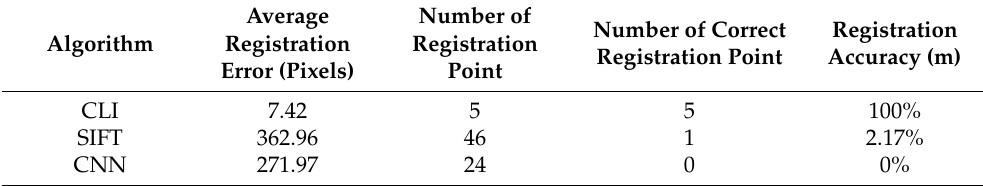
Table 8. Comparison of experiment results.